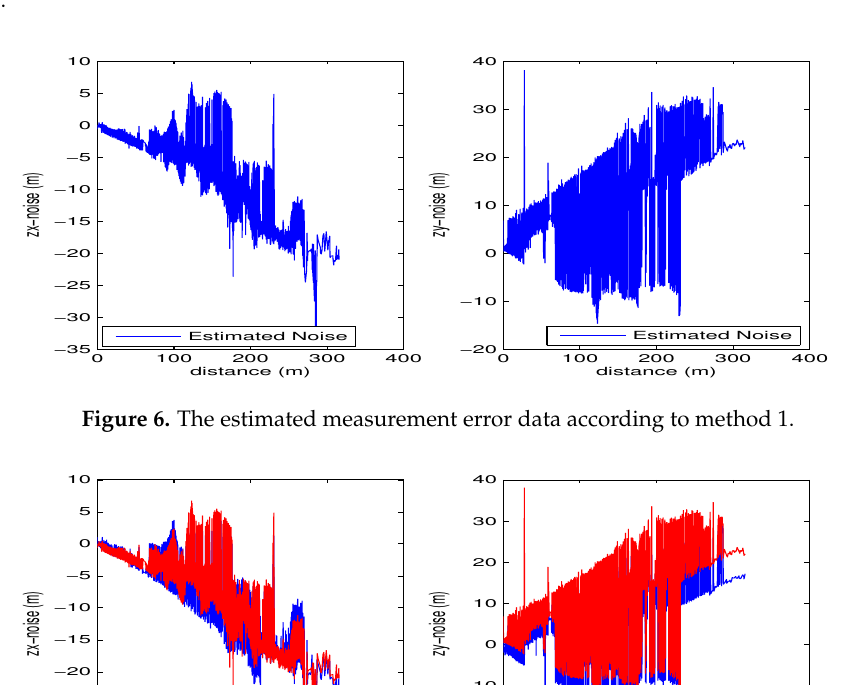
Figure 5. The true measurement error data between inertial measurement unit (IMU) and acoustic sensor.